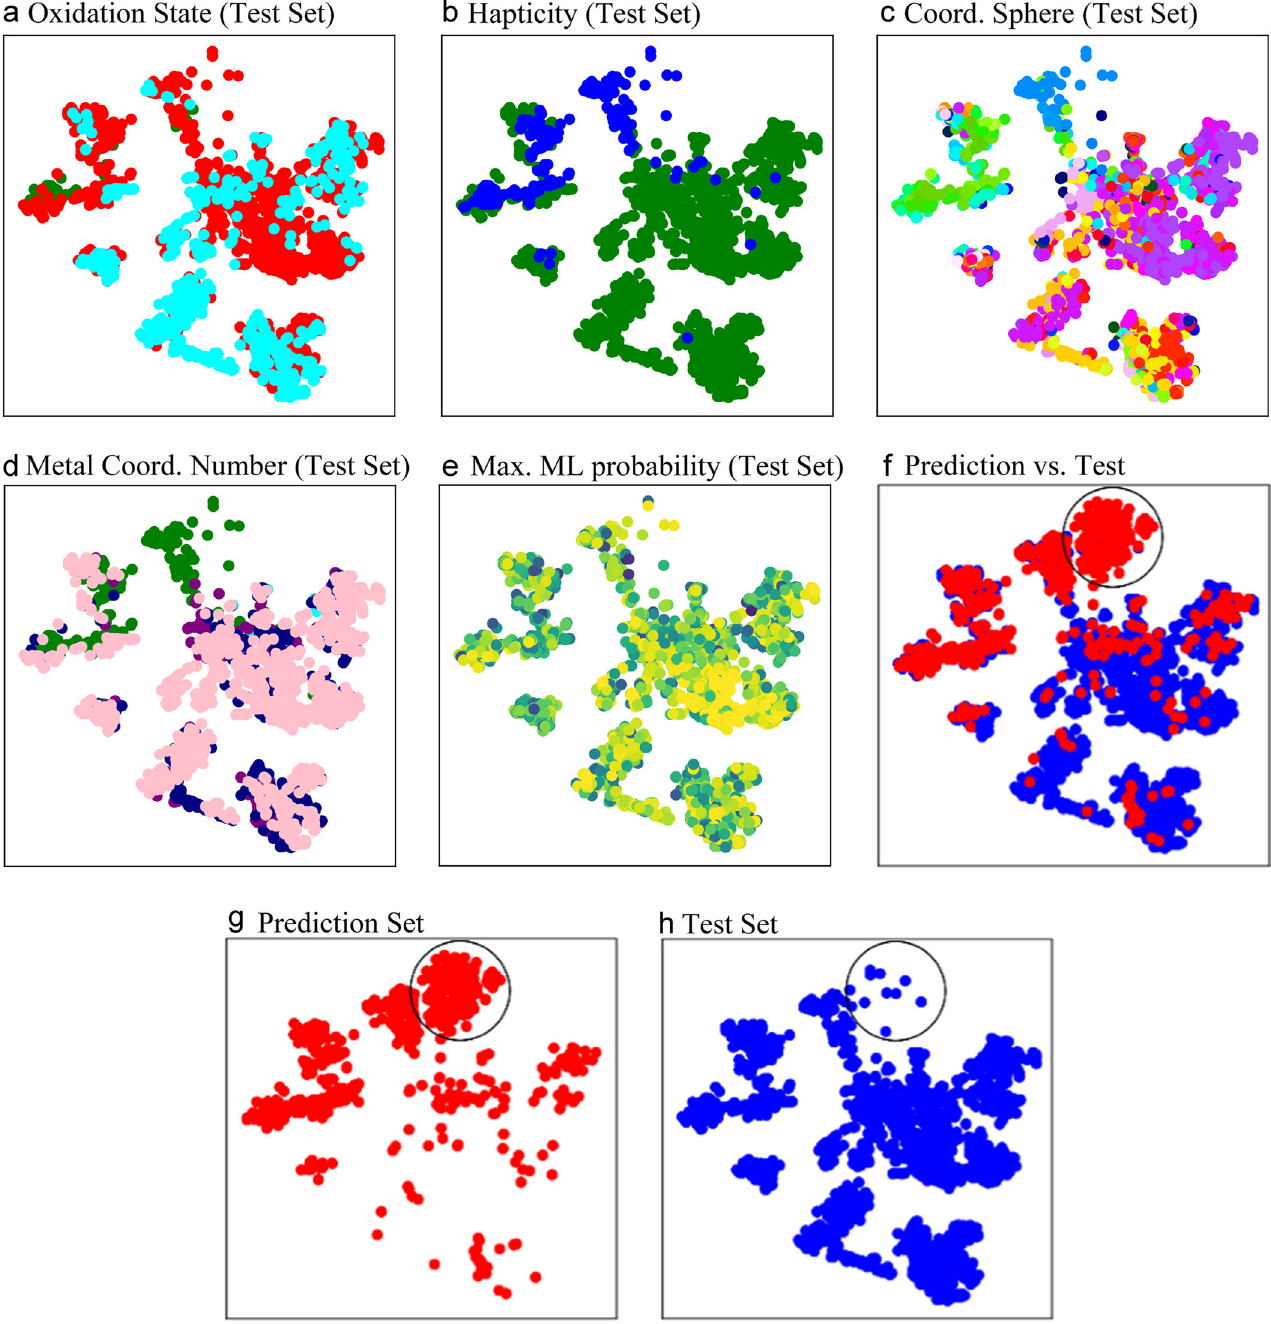
Fig. 4 Analysis of the chemical space covered by the Fe database and ML model performance. Representation of the chemical space in the Fe mono-metallic dataset using the t-SNE projection. Each point is one TM-complex in the database. Complexes are clustered by similarity in the local SLATM representation of their metal center describing the structure and chemical composition of the fi rst coordination sphere (see Methods). In the top panel, for the test set we show a the distribution of metal OS (0 = green, 2 = red, 3 = cyan), Oxidation State (Test Set), b the presence of at least one haptic ligand (green = no, blue = yes), Hapticity (Test Set), c the 385 coordination sphere types for Fe, Coord. Sphere (Test Set), and d the coordination number of the metal, with haptic ligands counting 0 towards this number (green = 0, cyan = 3, purple = 4, navy = 5, pink = 6), Metal Coord. Number (Test Set). In the below panel, we show the e the maximum probability associated with the ML prediction of the metal OS, as a measure of its con fi dence (yellow = 1, degrading to green = 0.5 and blue = 0) Max. ML probability (Test Set), and the f overlap between the prediction (red) and test (blue) sets, which are also shown separately in g and h . The black circle indicates a region with poor overlap. See Supplementary Notes 10 – 13 for other